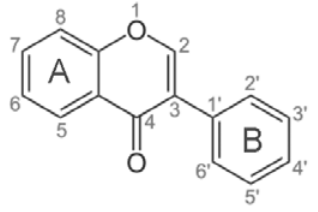
Figure 3. Numeration of atoms in the isoflavone